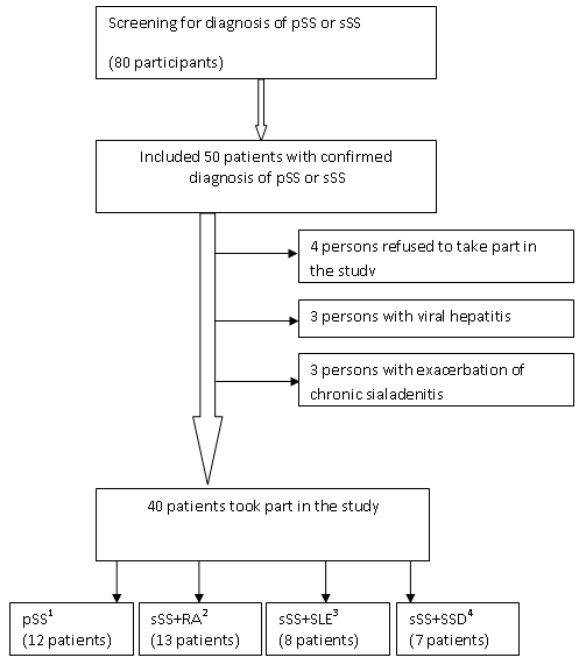
Figure 1. Patient flow diagram. 1 primary Sjogren’s syndrome; 2 secondary Sjogren’s syndrome, associated with rheumatoid arthritis; 3 secondary Sjogren’s syndrome, associated with systemic lupus erythematosus; 4 secondary Sjogren’s syndrome, associated with systemic